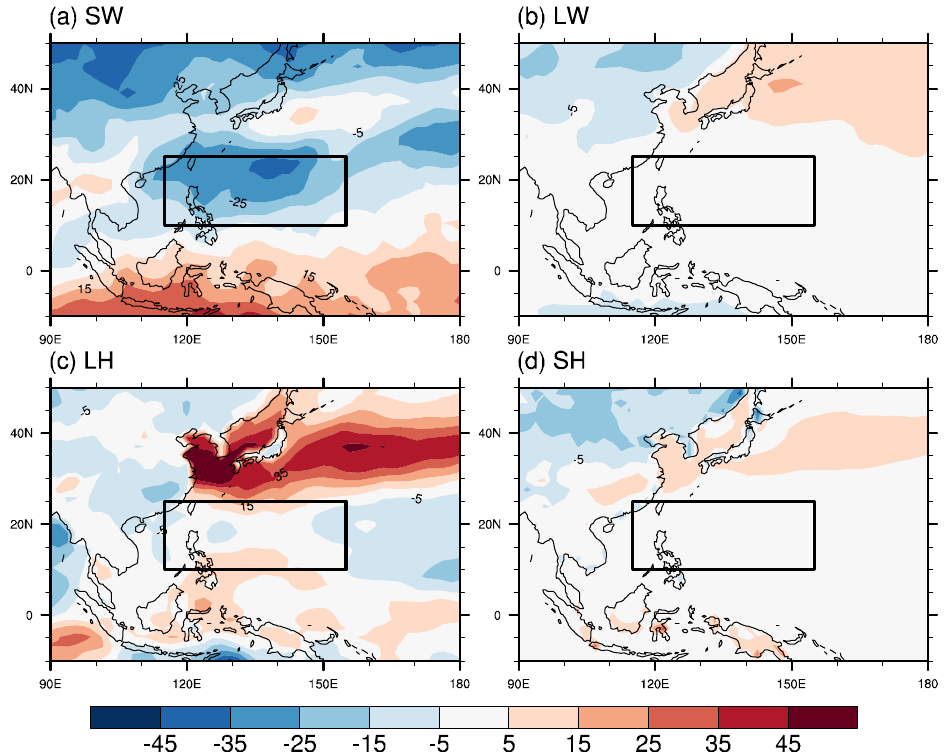
Figure 4. Climatological surface flux change in ( a ) shortwave, ( b ) longwave, ( c ) latent, and ( d ) sensible heat from July to August (units: W/m 2 ). The change means the difference between August and July. The black box denotes the region mainly focused on in this study (10–25° N, 115–155° E).